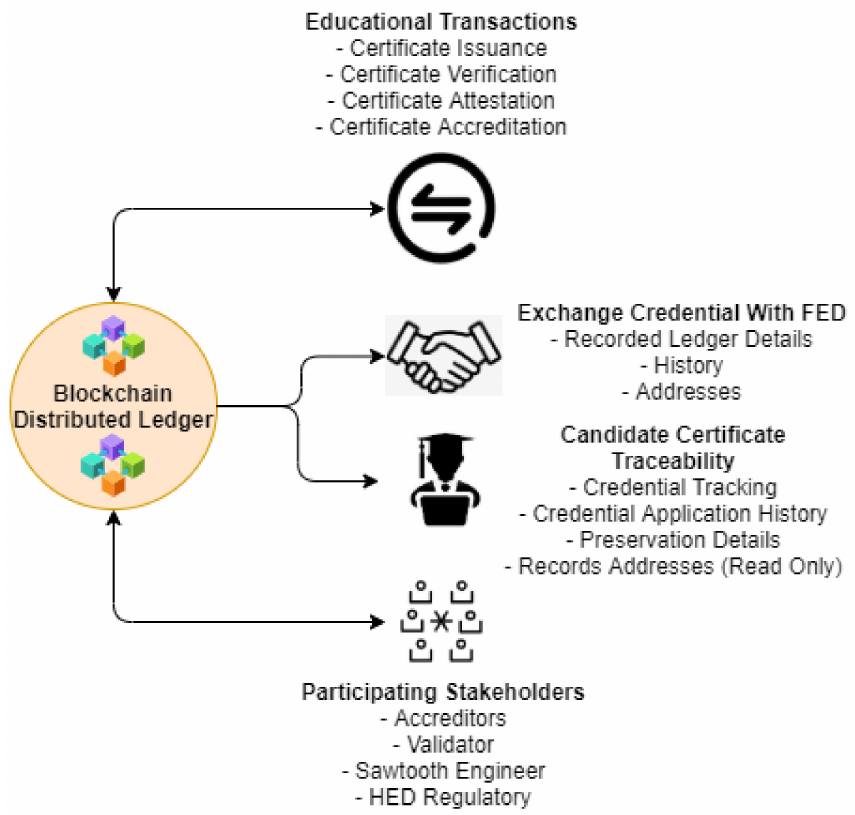
Figure 2. Blockchain educational distributed